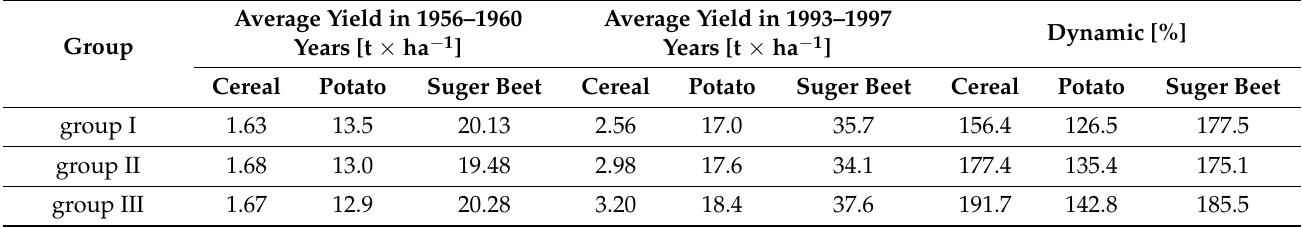
Table 3. The yield of selected crops and the dynamics of yield depending on the distance from the open-pits mines (according to the data from the analyzed voivodships).